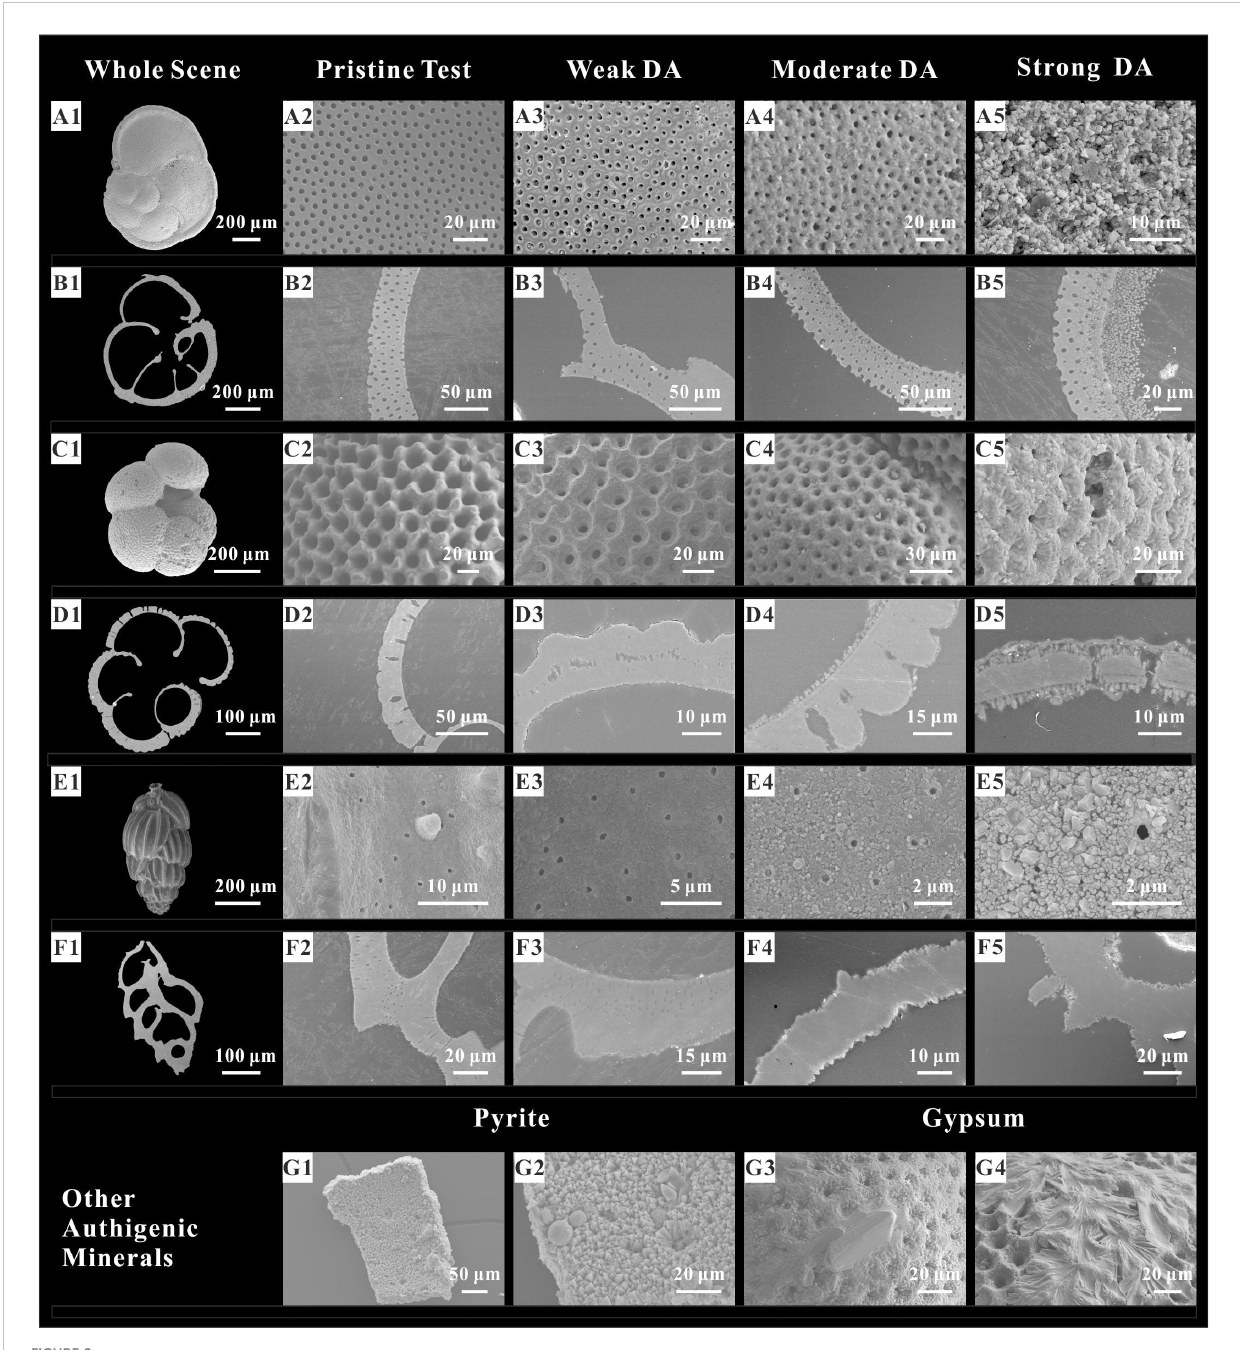
FIGURE 2 SEM images of foraminiferal tests representing a range of diagenetic alteration (DA) stages. Whole test, exterior wall, and wall cross-section views for G. menardii (A 1- B 5 ) , N. dutertrei (C 1- D 5 ) , and U. peregrina (E 1- F 5 ) . Authigenic pyrite framboids inside the test chamber (G 1-2 ) , and authigenic gypsum growing on the exterior wall (G 3-4 )